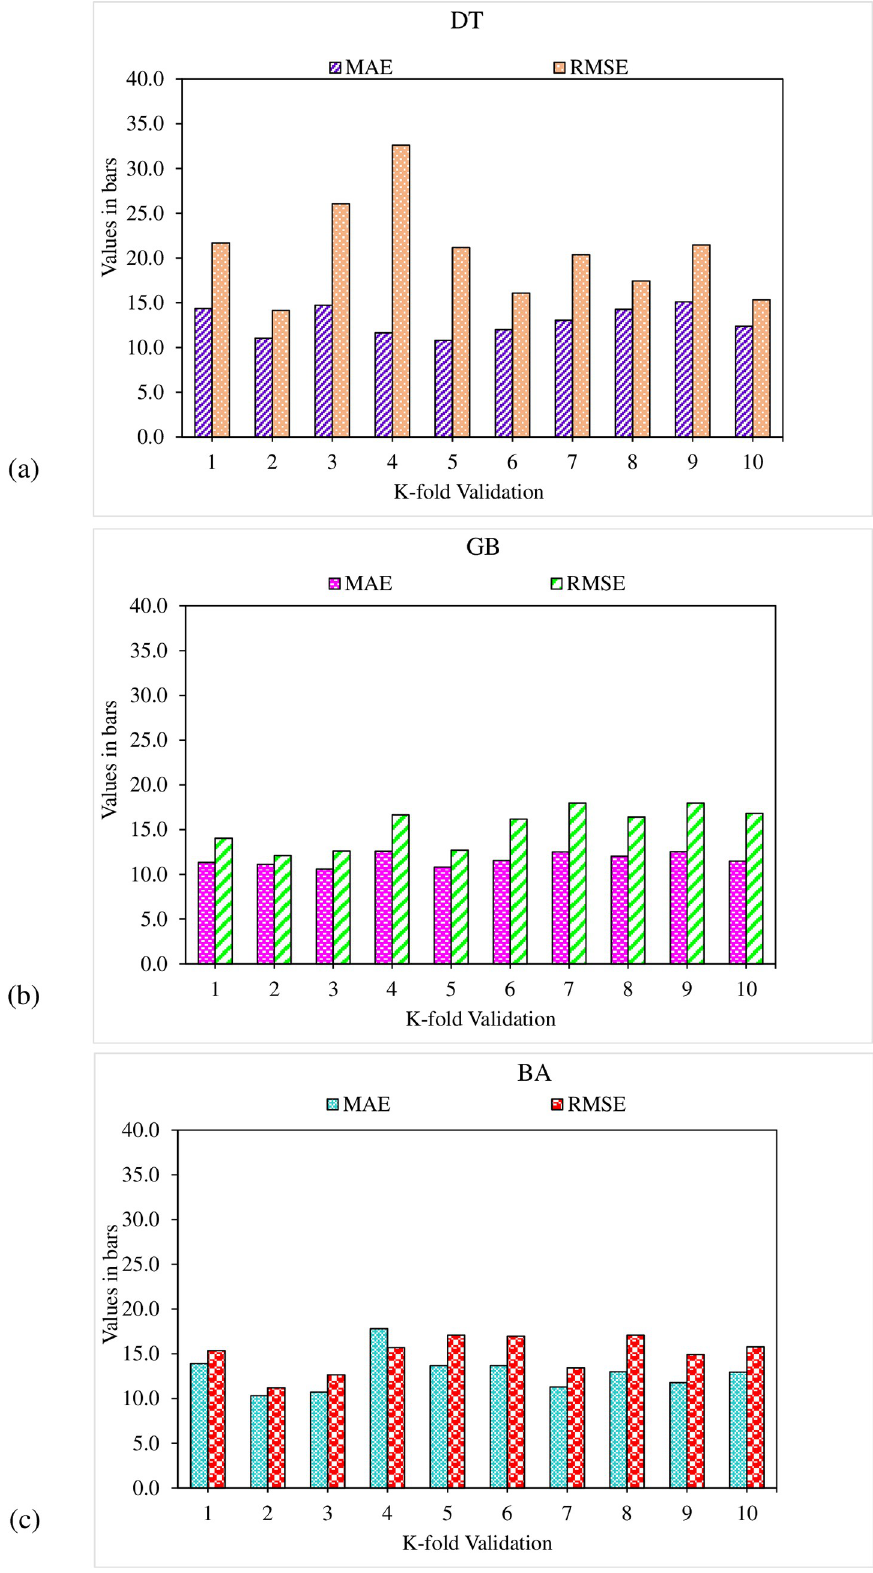
Fig 17. Compressive strength statistical representation: (a) DT; (b) GB; (c) BA.